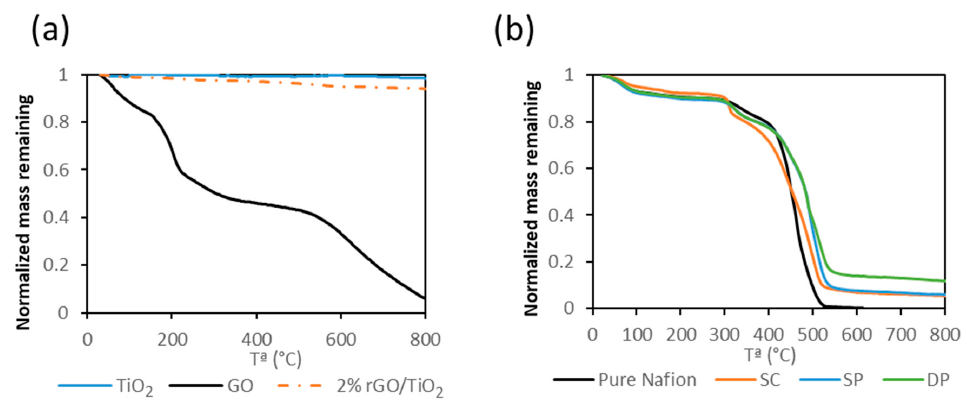
Figure 2. TGA of TiO 2 , pure GO and rGO/TiO 2 ( a ) . TGA of pure Nafion and photocatalytic membranes ( b